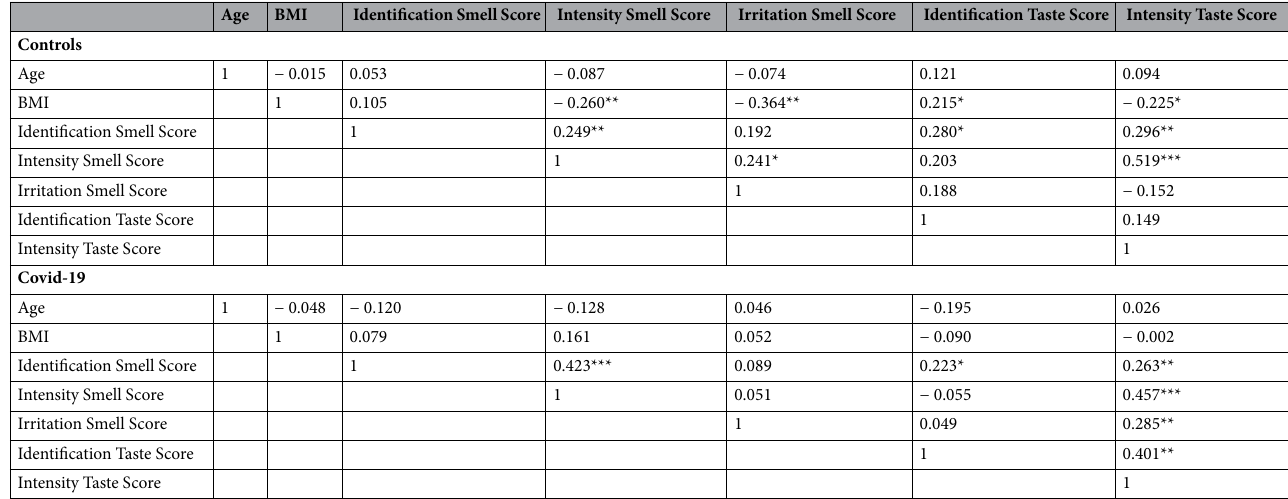
Table 2. Correlations among demographic factors (i.e., age and BMI) and the variables of interest related to smell and taste (Identification Smell Score, Intensity Smell Score, Irritation Smell Score, Identification Taste Score, Intensity Taste Score) in Control and COVID-19